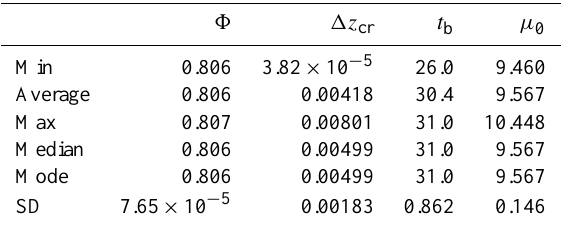
Table 5. Sorrento Peninsula case study. Statistics for the 100 best